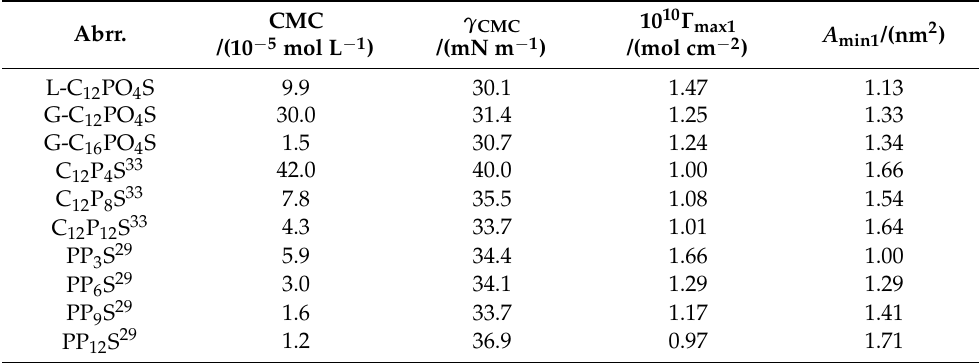
Table 1. The critical micelle concentration (CMC), γ CMC , and saturated adsorption amount ( Γ max1 ) and area ( A min1 ) of the surfactants.